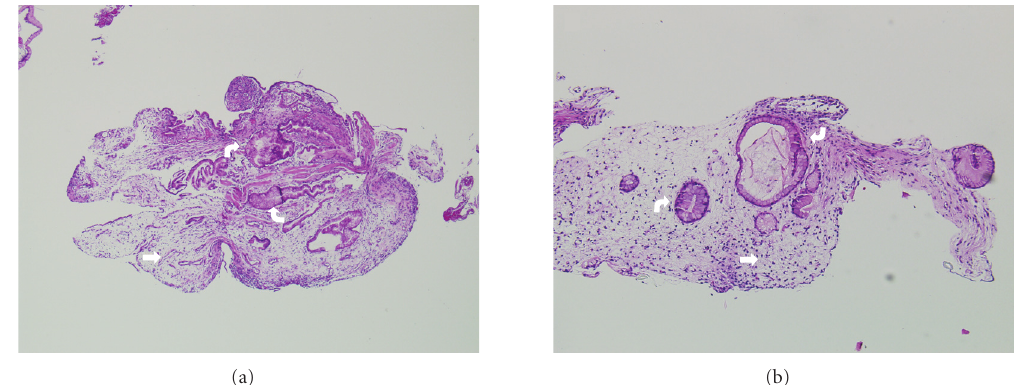
Figure 3: Histopathology of gastric mucosa. (a) Gastric polyp with hyperplastic features of foveolar epithelium (curved arrows) in a background of prominent lamina propria edema and inflammation (straight arrow). (b) Nonpolypoid gastric mucosa. Similar features are present; hyperplastic epithelium (curved arrows) and lamina propria edema (straight arrow) as in Panel